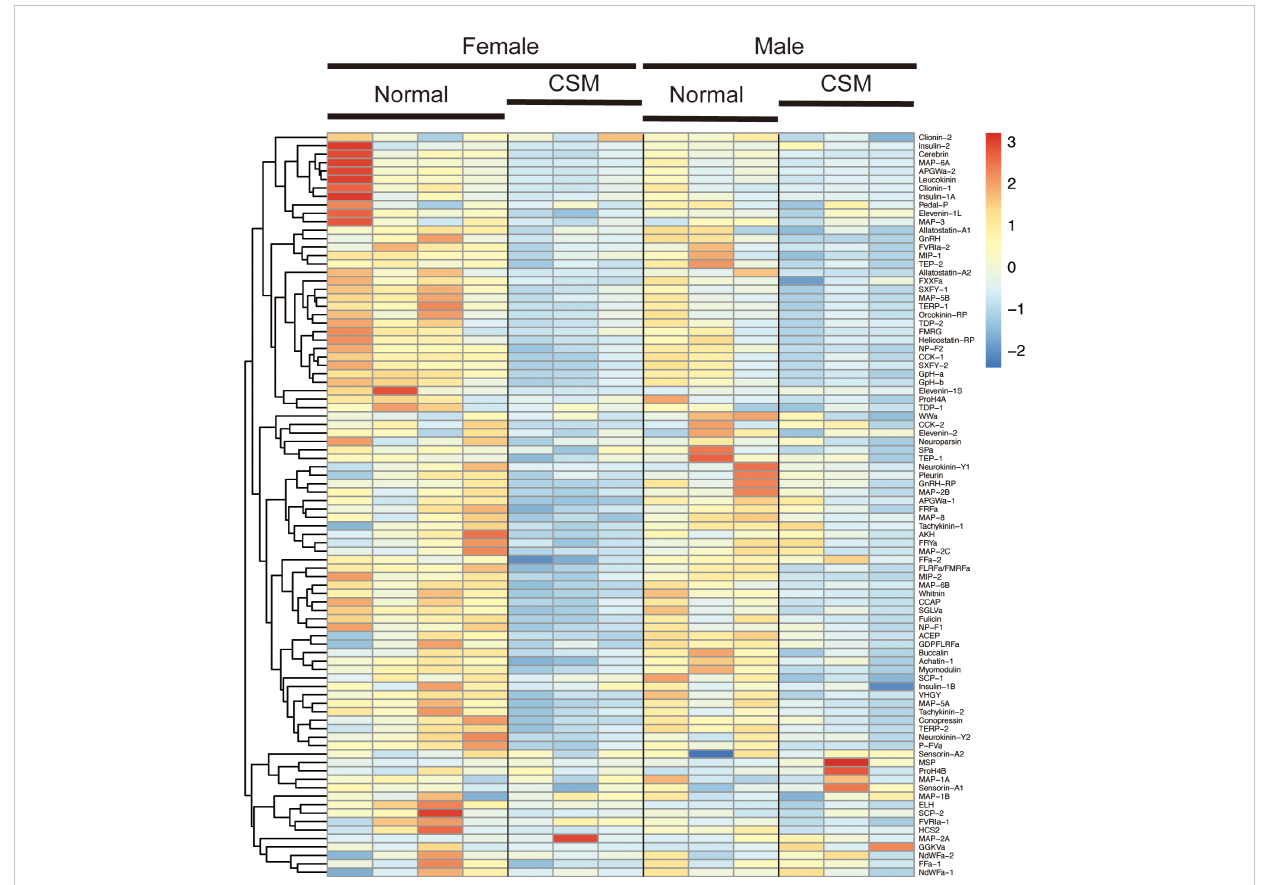
FIGURE 3 Hierarchically clustered heatmap showing the expression of neuropeptide precursor in the ganglia of the normal and CSM snails. Heatmap representation of differences in expression levels of neuropeptide precursors between the normal and CSM snails was made by calculating the Z-score. Note that over all expression levels of neuropeptide precursors in CSM snails were lower than those in normal